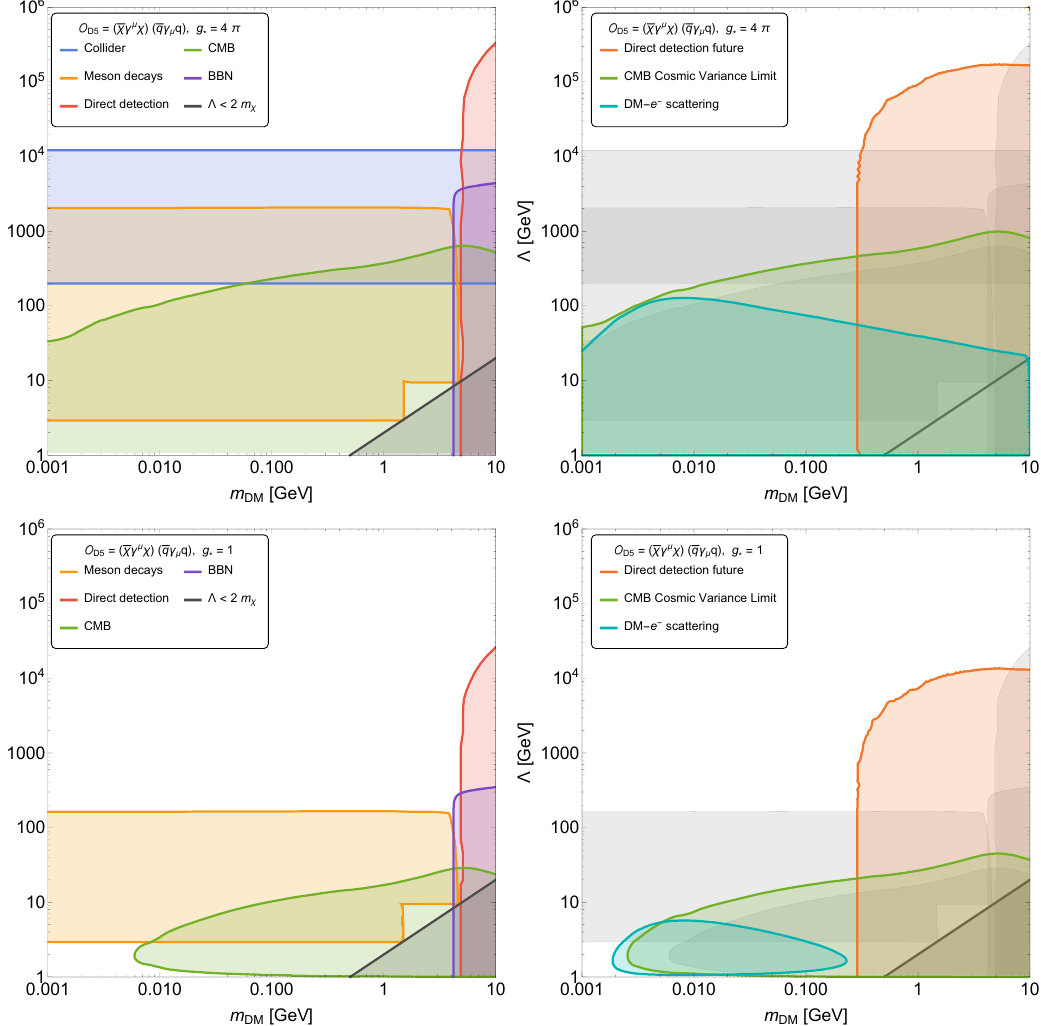
Figure 1 . Experimentally excluded region in the ( m DM ; (cid:3)) parameter space for the case of SM singlet Dirac fermion dark matter with (cid:13)avour universal couplings with quarks. In the left panels the blue, red, yellow, green and purple regions are ruled out respectively by collider (LEP and LHC), direct detection (LUX), meson decays (BaBar and BES), CMB experiments and BBN. The grey region represents the limit of validity of the EFT, (cid:3) < 2 m DM . In the right panel the green, emerald and orange regions will be probed respectively by future CMB, DM electron scattering and direct detection (SuperCDMS) experiments, while the grey area is already excluded by current experiments. The two upper panels consider an e(cid:11)ective coupling g (cid:3) = 4 (cid:25) for current (left) and future (right) experiments. The lower panel shows results for an e(cid:11)ective coupling g (cid:3) = 1.